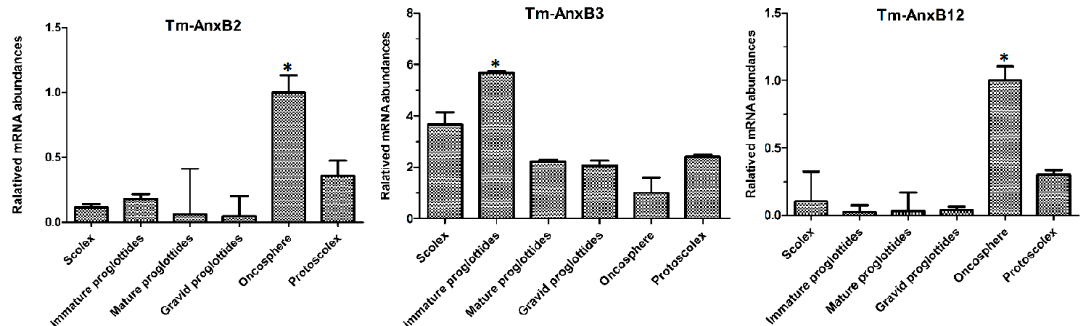
Figure 8. Differential transcription levels of TmAnxB2, TmAnxB3 and TmAnxB12 in different proglottids and developmental stages of T. multiceps . Levels of expression were determined using the ∆∆ Ct method. Data are represented as the means ± SD ( n = 3). Asterisks indicate fold changes that were statistically significant at p < 0.05.